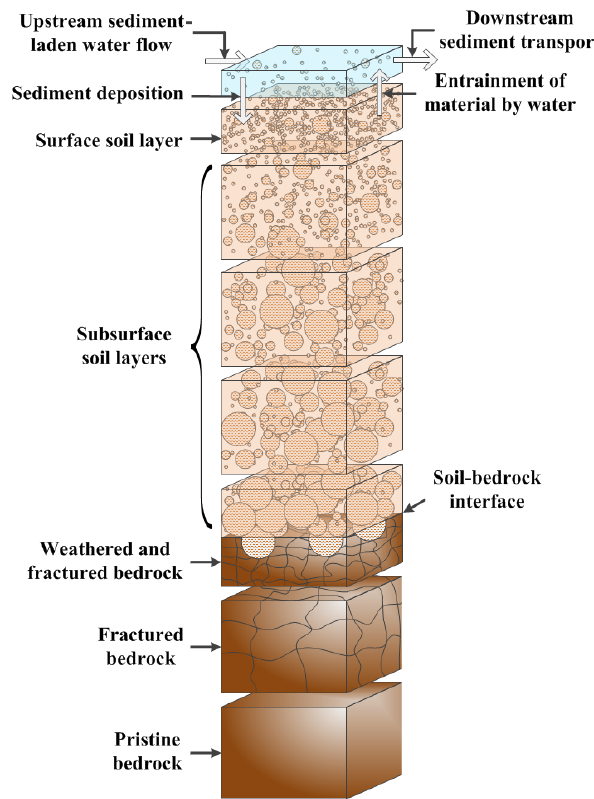
Figure 1. Schematic diagram of the SSSPAM